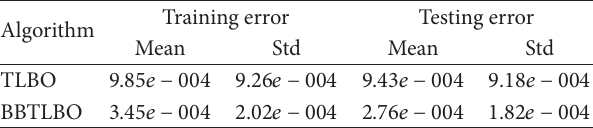
Figure 6: Comparison of the performance curves using different algorithms. Table 6: Comparisons between BBTLBO and other algorithms on